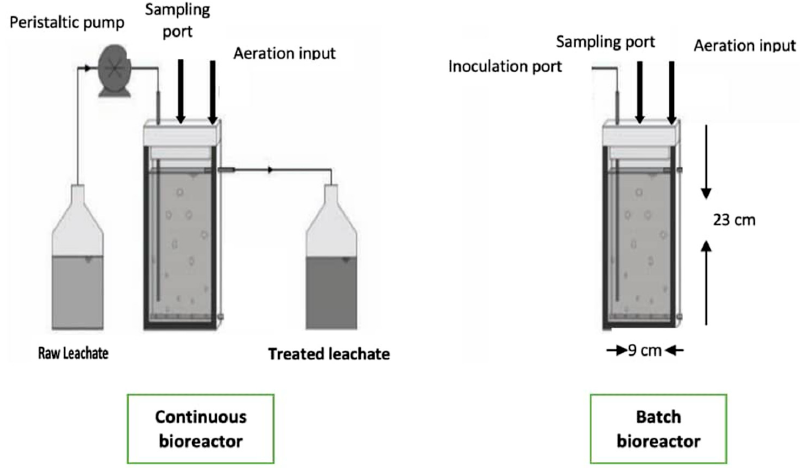
Figure 1. Batch and continuous bioreactors used for raw leachate treatment.